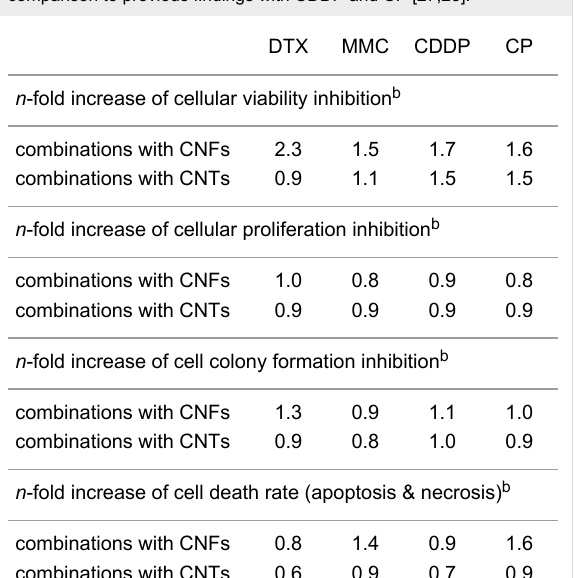
Table 3: Effects of combinatory treatments with DTX and MMC in comparison to previous findings with CDDP and CP [27,28].